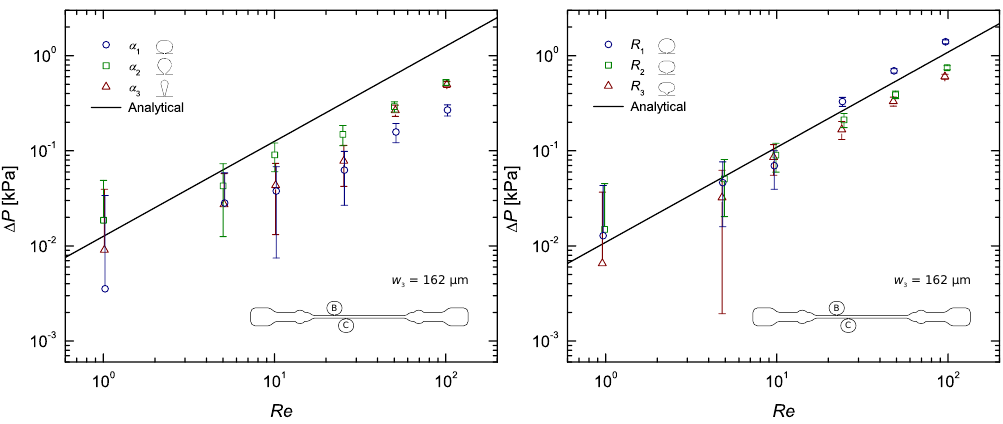
Figure 4. Steady-state pressure drop measurements as a function of the Reynolds number for the flow of DI water along a rectangular microchannel (section BC), compared with the analytical solution (Equation (2)): Pressure taps with sub-channel widths w 1 , w 2 and w 3 ; α taps on the left and R taps on the